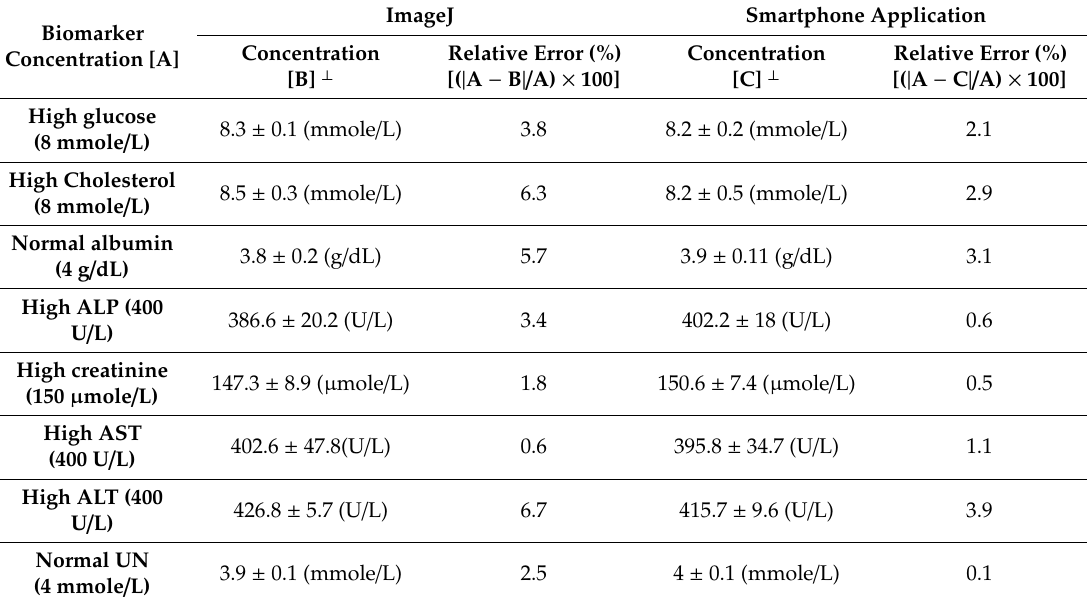
Table1. ConcentrationsofbiomarkersbasedongrayintensitiesmeasuredbyImageJandthesmartphone application with the photo box. Biomarkers at di ff erent concentrations were prepared by dissolving known concentrations of the biomarkers in PBS before testing. The mean and standard deviation of each biomarker were obtained from the measurement of gray intensity on three di ff erent µ PADs devices with nine detection zones. Device-to-device relative standard deviation (RSD) was less than 5% (1.2% for glucose, 3.2% for cholesterol, 4.7% for albumin, 2.8% for ALP, 3.7% for creatinine, 0.9% for AST, 4.4% for ALT, and 3.1% for UN).